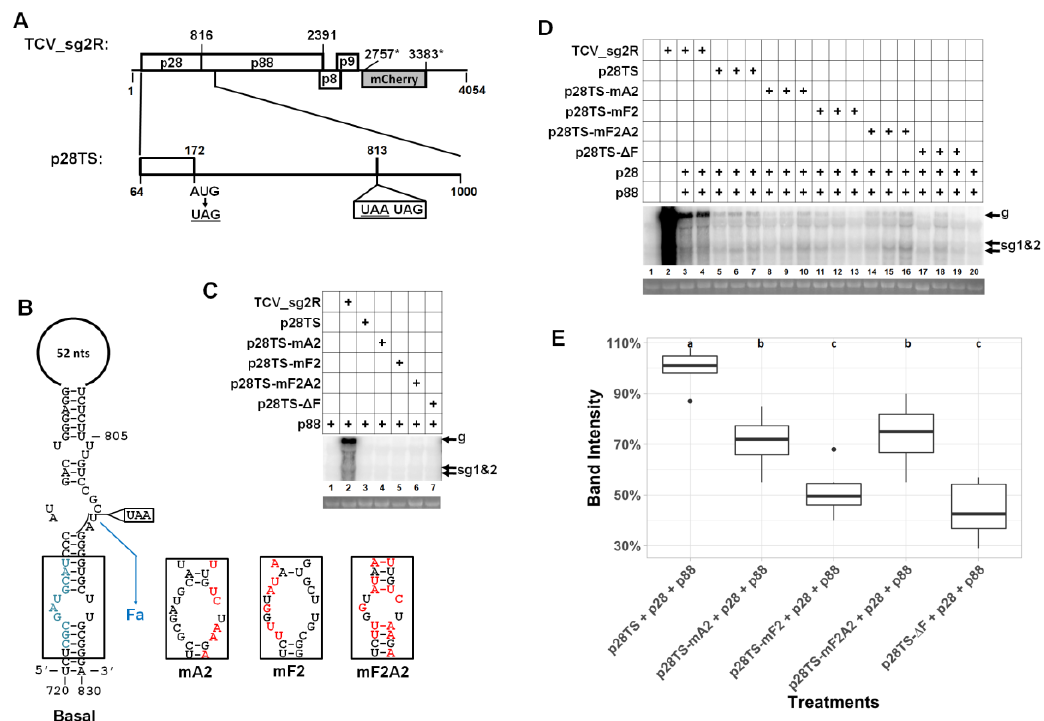
Figure 5. Interrogation of an RNA element within the p28 coding sequence by providing both p28 and p88 in trans . ( A ) Schematic depiction of the p28TS mutant replicon encoding neither p28 nor p88, with the positions of three stop codons shown. ( B ) The Basal RNA structure involving mostly p28 coding sequence. Note that this structure is mutually exclusive with RSE because, in this structure, the Fa element pairs with the Ff element (in blue letters) within the p28 coding sequence. Accordingly, the mA2 mutations shown in Figure 2 now disrupt the FfFa stem structure. Two additional mutants, mF2 and mF2A2, were also tested, along with a Ff deletion mutant ( ∆ F). All mutants were based on p28TS. ( C ) Northern blotting showed that, unlike earlier mutants, these mutants did not replicate in the presence of trans p88 alone. ( D ) Northern blotting revealed a modest role of Ff in TCV gRNA accumulation. ( E ) Quantification of Northern botting results of multiple repeat experiments.